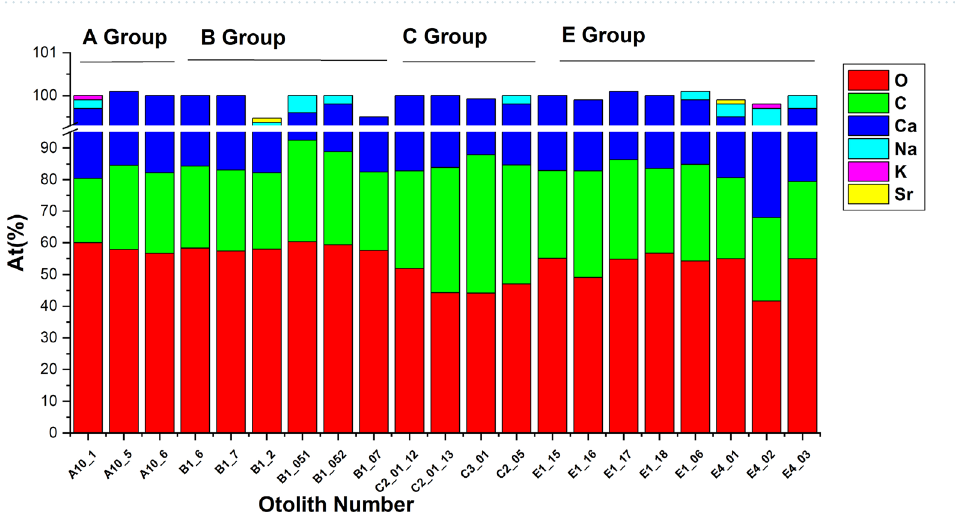
Figure 7. EDX comparative data on the four otolith groups showing the atomic weight At (%) plotted for O, C, Ca, Na, K and